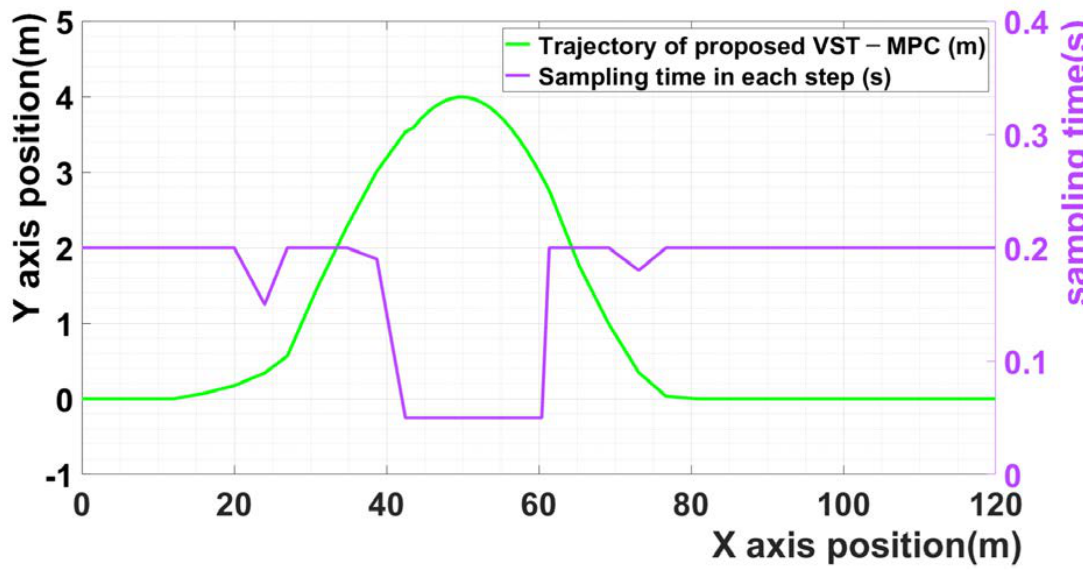
Figure 8. The sampling time of scenario 2 in each step. Figure 9 compares the trajectories of the four MPC algorithms. The black curve is the reference trajectory, the red curve represents the MPC algorithm with a 0.2 sampling time, the blue curve represents the MPC algorithm with a 0.1 sampling time, the green curve represents the proposed MPC algorithm, and the brown curve represents the MPC algo- rithm with a 0.05 sampling time. The proposed VST-MPC is closest to the reference trajec- tory compared to the MPC with a 0.1 sampling time and the MPC with a 0.2 sampling time. This indicates that the path-following performance is improved by the effect of the proposed VST-MPC. Additionally, the proposed VST-MPC shows similar tracking per- formance to the MPC with a sampling time of 0.05. However, in terms of computation time, the proposed MPC improves over the MPC with a sampling time of 0.05. This is discussed in detail in Table 3. Figure 9. Comparison of trajectories of four MPC algorithms.